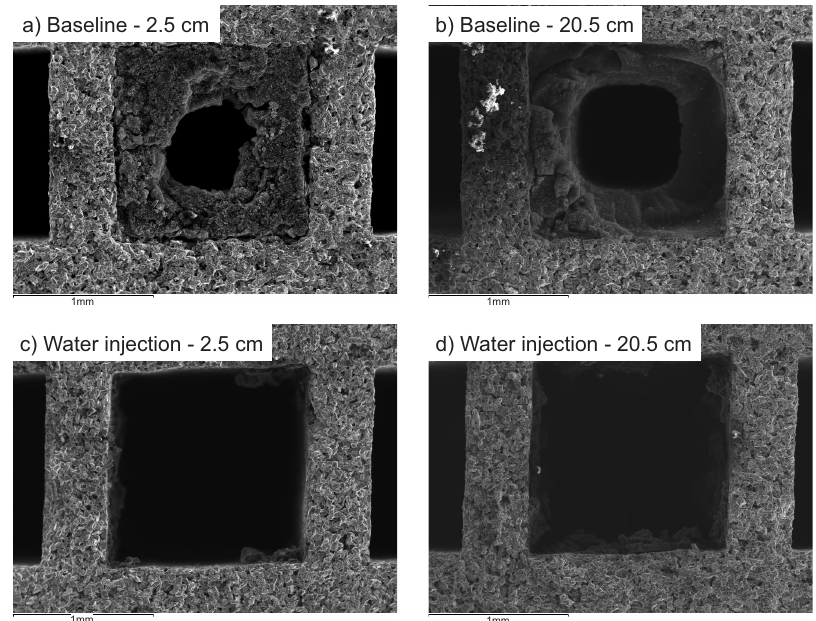
Figure 3. Scanning Electron Microscope (SEM) pictures of the cross-section of DPF #B inlet channels with the same soot loading at different locations in baseline and after water injection conditions: ( a ) baseline at 2.5 cm; ( b ) baseline at 20.5 cm; ( c ) pre-DPF water injection at 2.5 cm; ( d ) pre-DPF water injection at 20.5 cm.